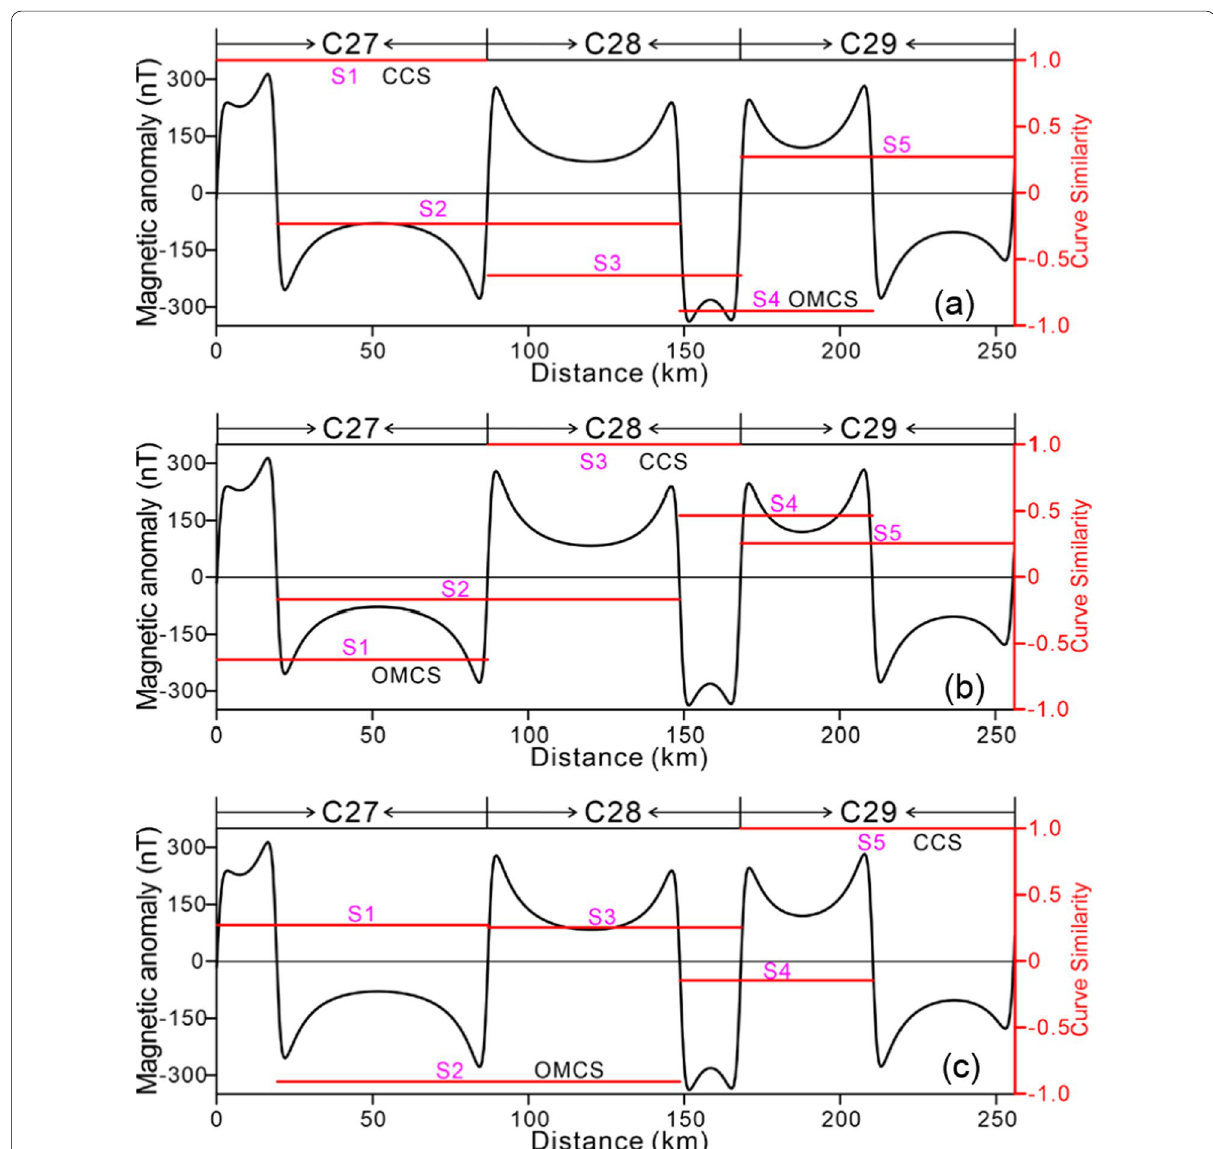
Fig. 4 Identification results of magnetic anomalies of polarity chron C27-29 by the SWCS method. a The identification results of polarity chron C27. b The identification results ofpolarity chron C28. c The identification results of polarity chron C29. The red lines represent the values of the curve similarity in different steps (Magenta marks). The CCS represents the curve similarity between the theoretical window and the observed magnetic anomalies at the position of the corresponding steps. The OMCS represents the maximum absolute curve similarity values between the theoretical window and the observed magnetic anomalies at the position outside of the corresponding